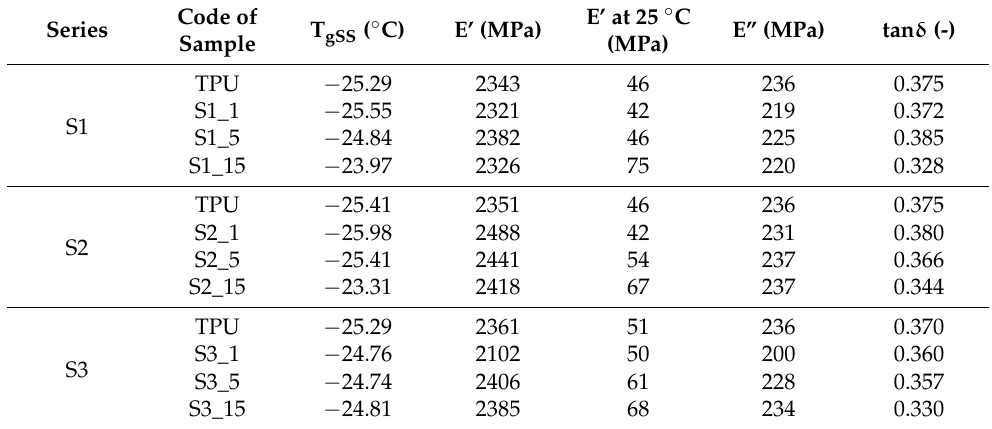
Table 2. Dynamic mechanical properties of bio-TPU matrixes and bio-TPU–ABW